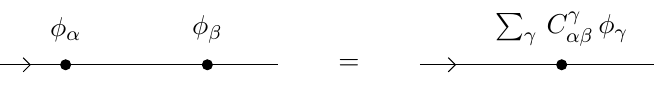
Figure 1 . The OPE of defect